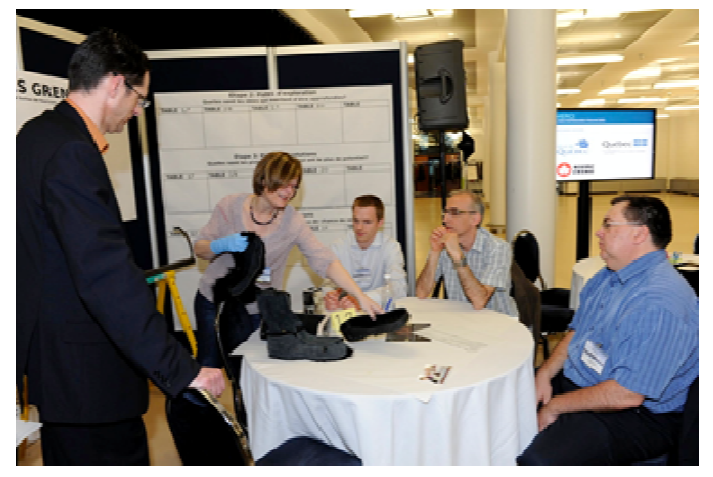
Fig. 3. Solving a fur boots